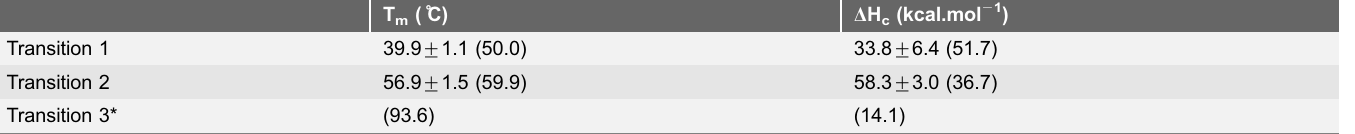
Table 1. Thermodynamic parameters for the thermal unfolding of C-214-HrpZ Pss .